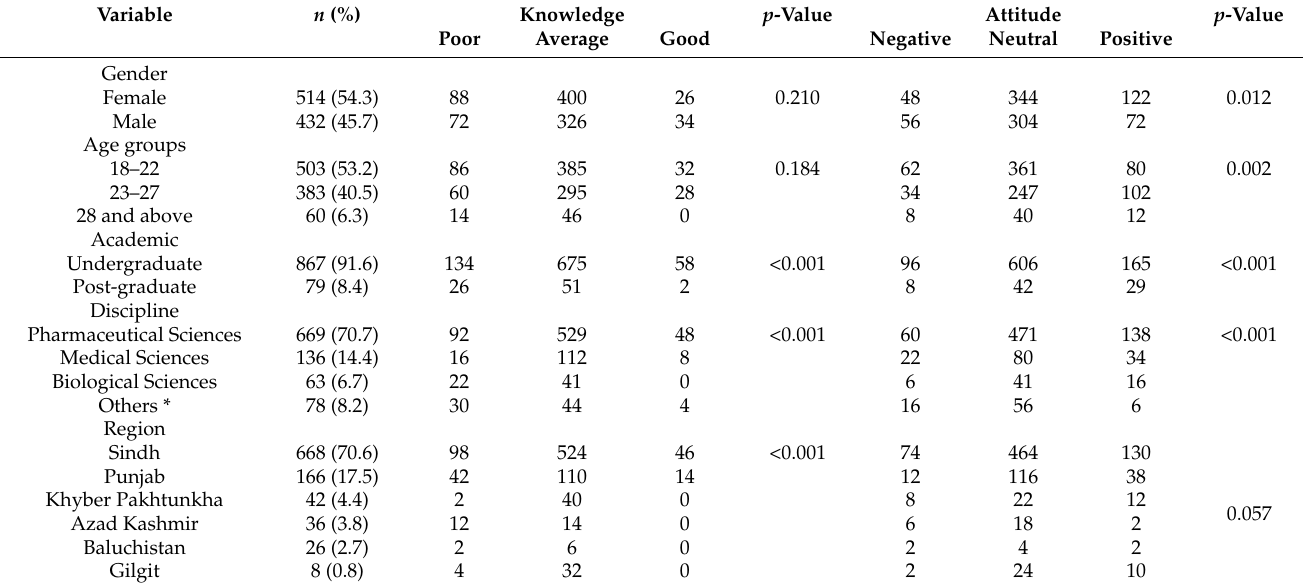
Table 4. Association between socio-demographics with knowledge and attitudes regarding